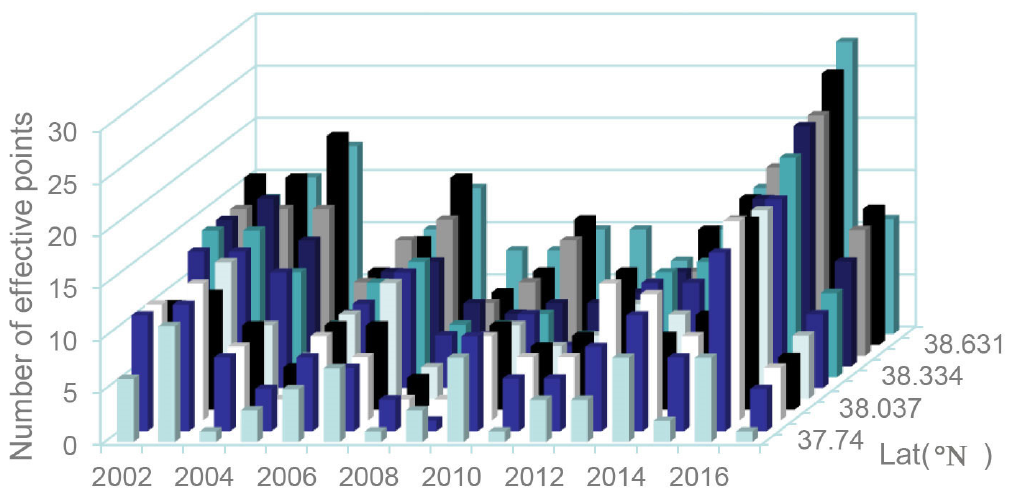
Figure 6. E ff ective data volume of satellite images at di ff erent locations in the Bohai Figure 6. Effective data volume of satellite images at different locations in the Bohai Strait.